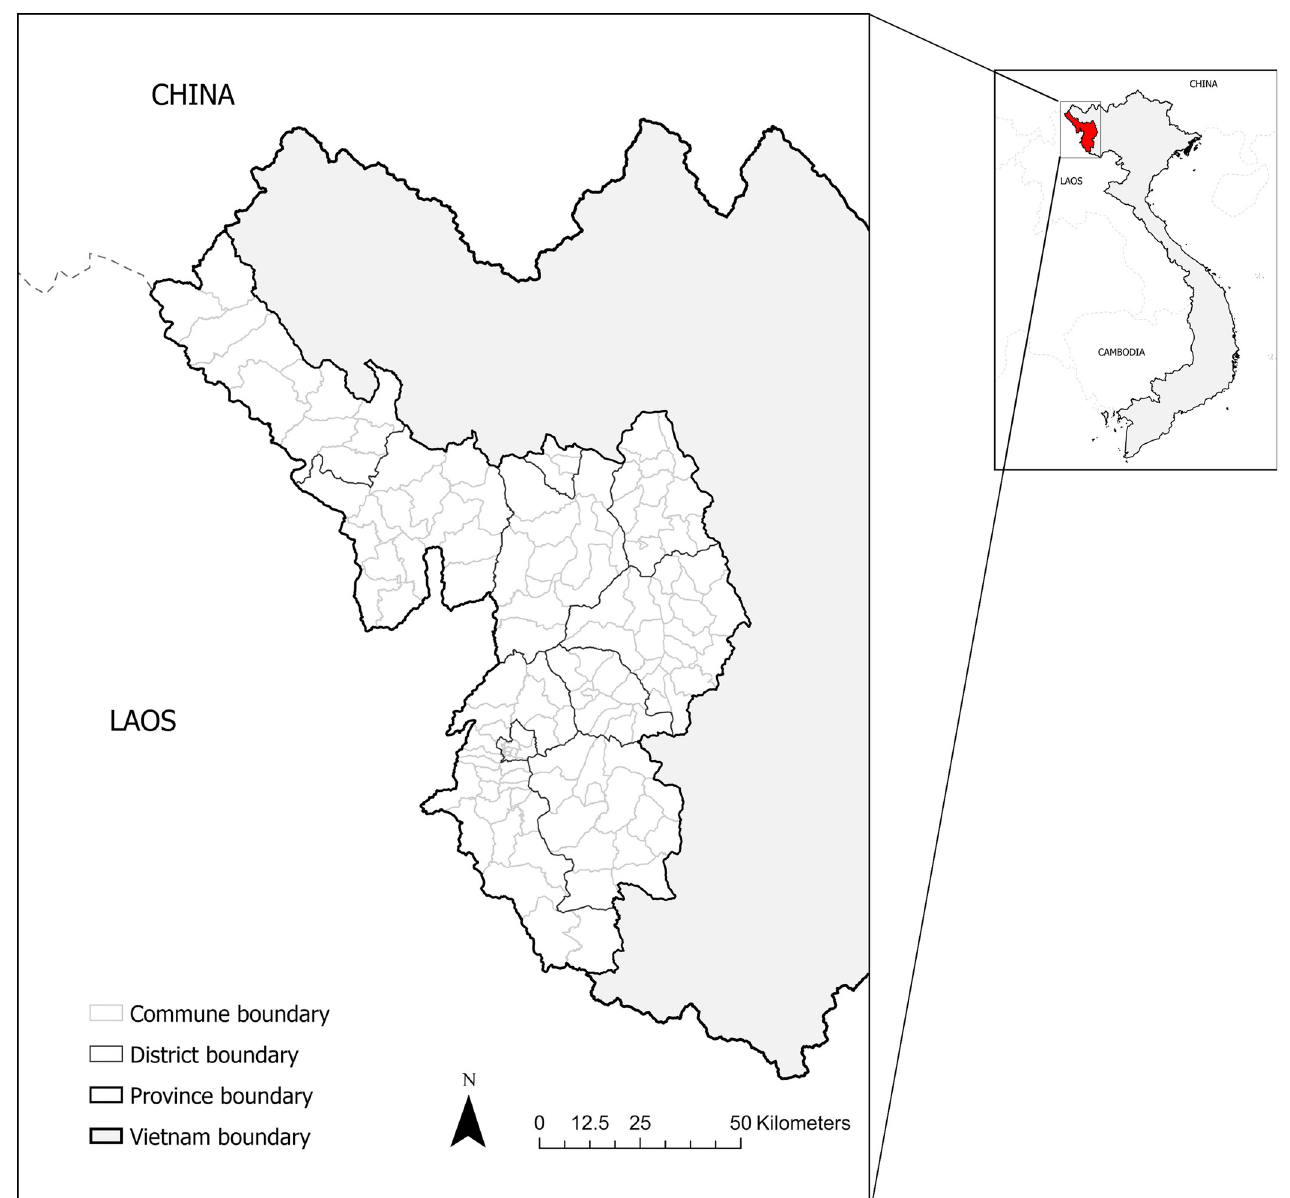
Fig 1. Districts and communes within Dien Bien province in northwestern Vietnam (produced in ArcGIS Pro using political boundary shapefiles from https://geodata.ucdavis.edu/gadm/gadm4.1/shp/gadm41_VNM_shp.zip). https://doi.org/10.1371/journal.pntd.0010942.g001 (116/130, 89%) [14]. The three-level administration of Dien Bien province is illustrated in S1 Fig.